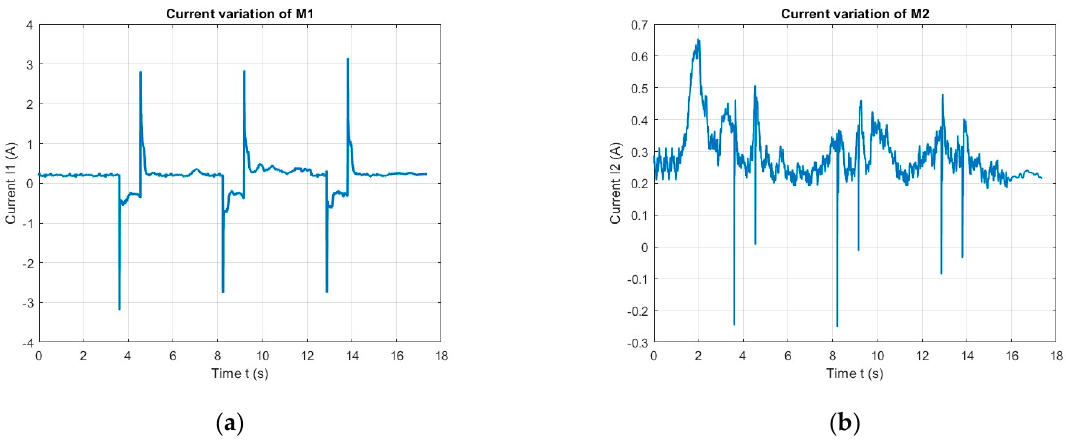
Figure 39. Current variation measured using the functional model for moving on the predefined path. ( a ) Wheel 1. ( b ) Wheel 2.